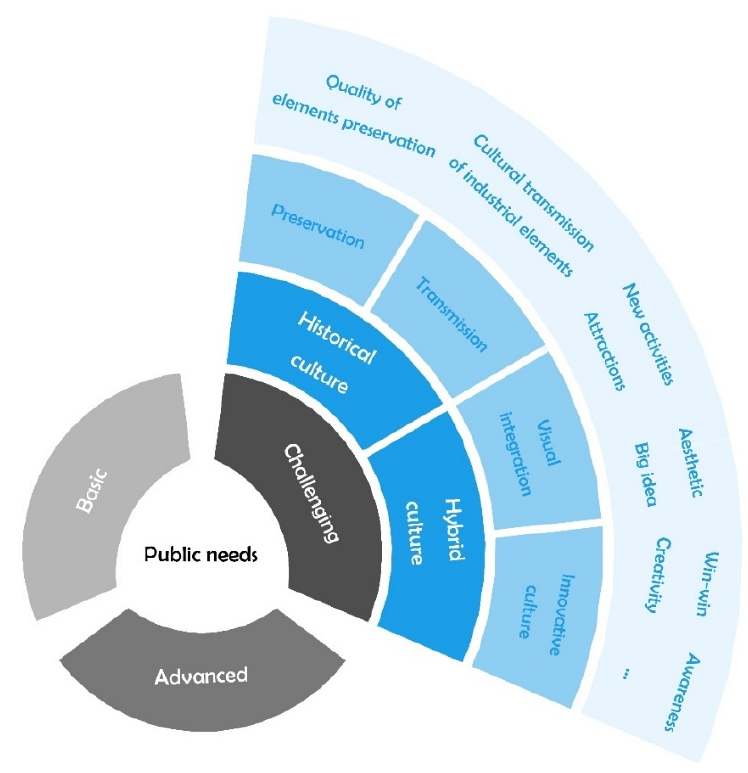
Figure 5. Measuring framework of challenging needs (by author, 2022).